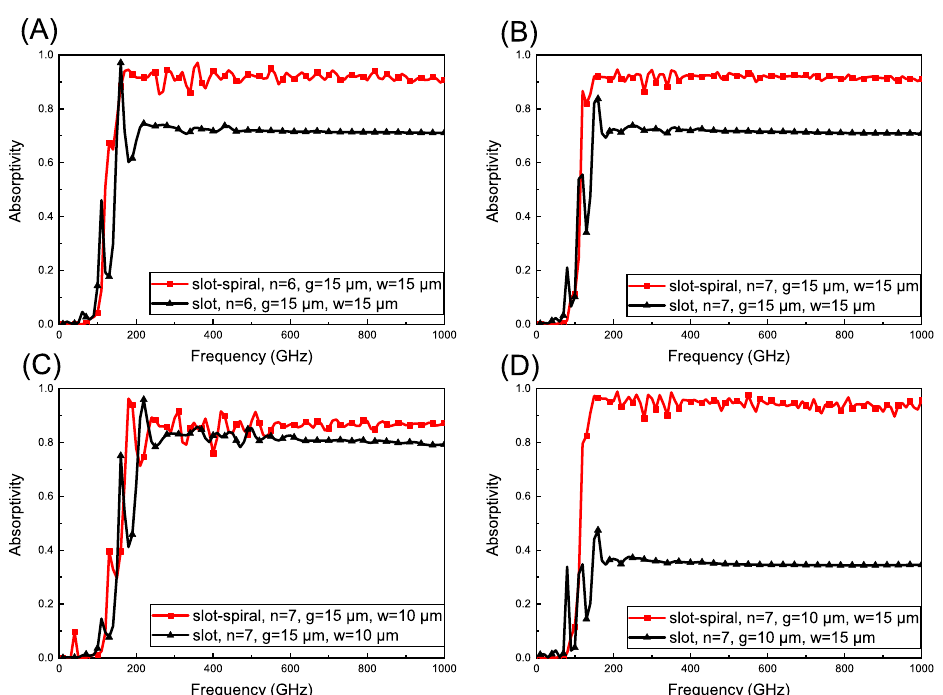
Figure 7. Comparisons of slot-spiral structure with the spiral structure of different structure parame- ters: ( A ) n = 6, g = 15 µ m, and w = 15 µ m; ( B ) n = 7, g = 15 µ m, and w = 15 µ m; ( C ) n = 7, g = 15 µ m, and w = 10 µ m; and ( D ) n = 7, g = 10 µ m, and w = 15 µ m.